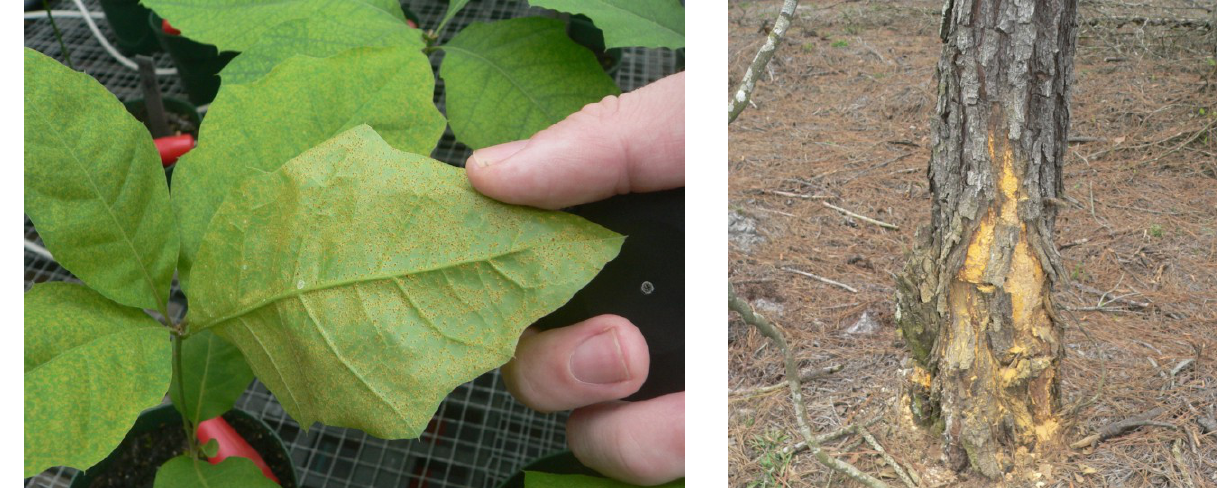
Figure 1. Fusiform rust, aecia on infected stem of slash pine right, and telia on infected leaf of northern red oak ( Quercus rubra ) on left. The pathogen is a macrocyclic, heteroecious rust fungus that alternates between the leaves of red oaks ( Quercus section Lobatae) and stems of pines ( Pinus section Diploxylon). Damage to oaks is minimal, but can be severe to pines.